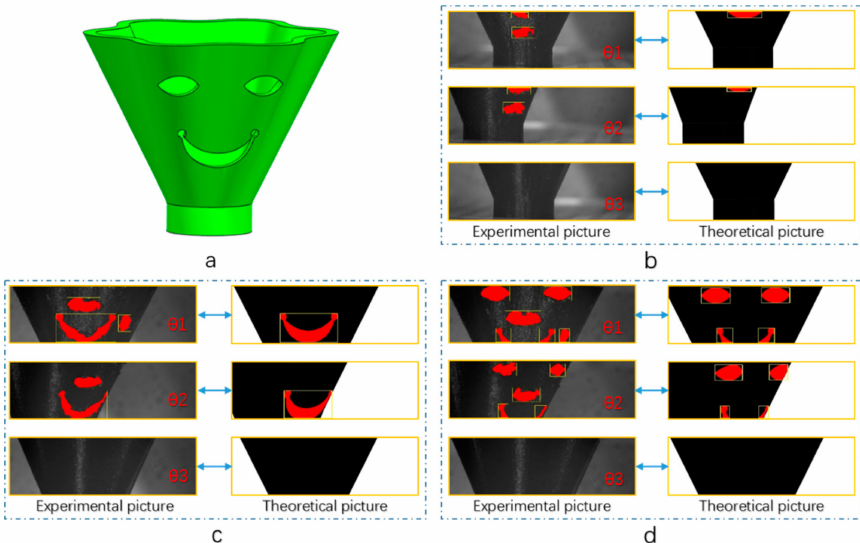
Figure 6. Some on-line test pictures during the experiment: ( a ) Theoretical model; ( b – d ) Experimental and theoretical results of randomly selected vertical acquisition nodes. θ 1 θ 2 θ 3 is the image from di ff erent angles in the printing process under the current height